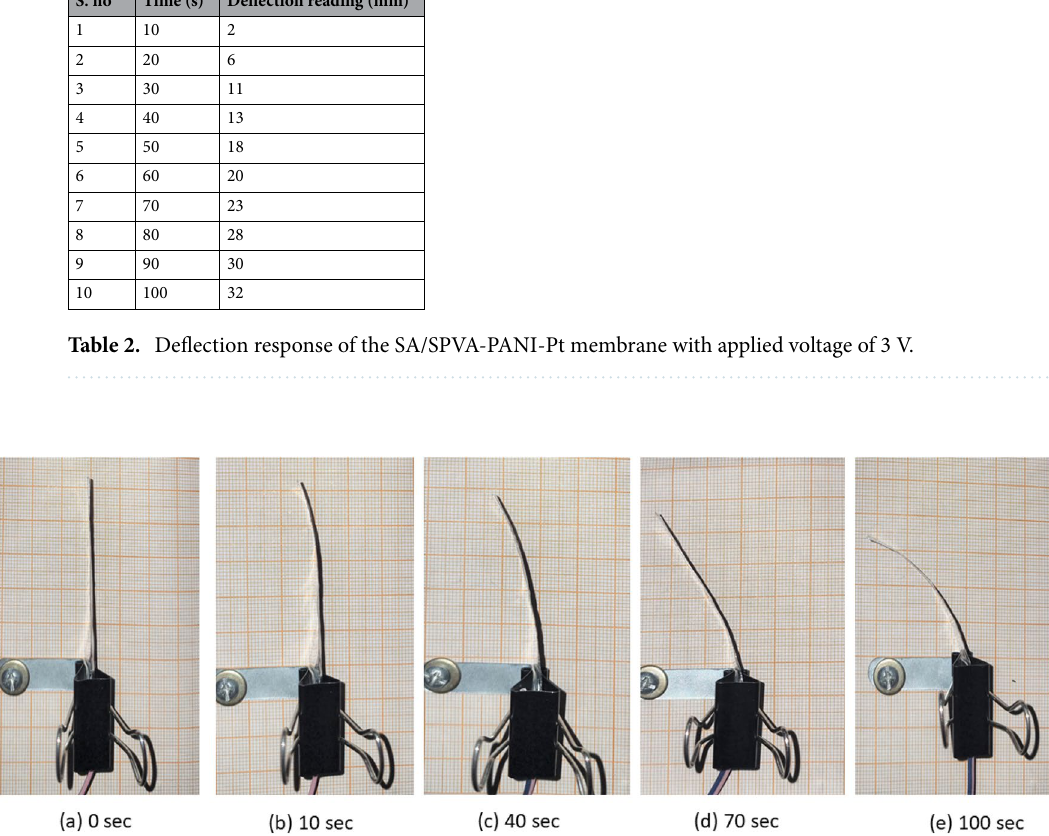
Figure 7. Experimental tip displacement response of SA/SPVA-PANI-Pt membrane with applied voltage of 3 V at 0, 10, 40, 70 and 100